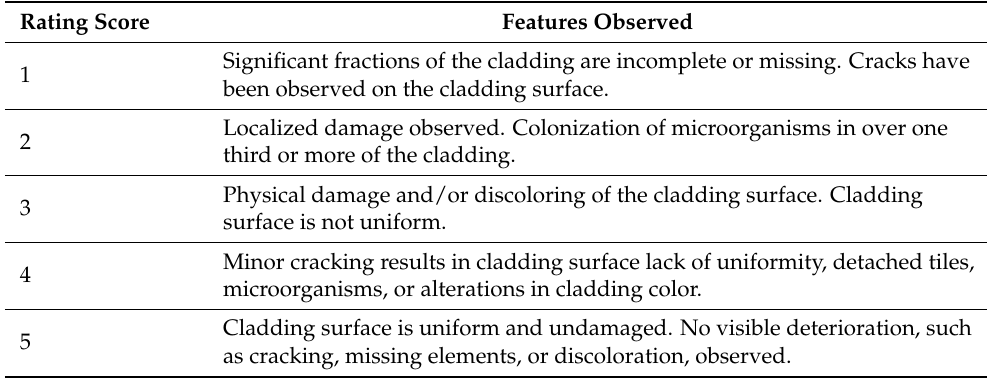
Table 2. Visual rating score, Shohet and Paciuk